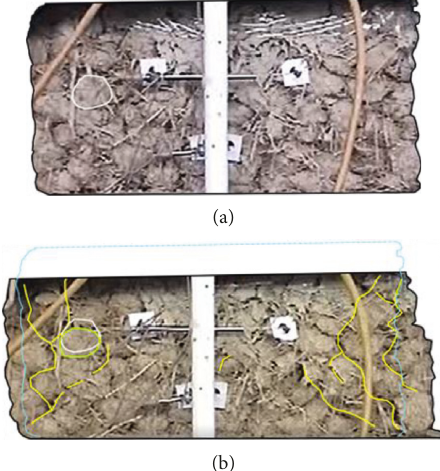
Figure 8: (a) Initial state and (b) typical crack pattern after the reaching of compressive strength. The flattening of a single cob element is also highlighted. Yellow lines: cracking; white line: un- deformed shape of the cob element before testing; green line: de- formed shape of the cob element after testing; blue dotted line: cob wall in undeformed shape.